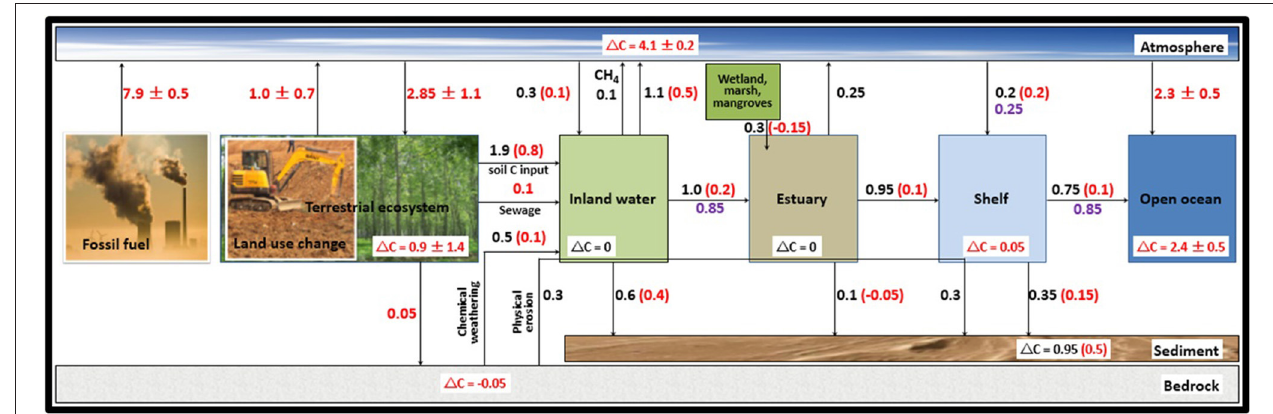
FIGURE 2 | Simplified schematic of the global carbon budget and its anthropogenic perturbation. All fluxes are in Pg C yr − 1 , rounded to ± 0.05 Pg C yr − 1 and represent the total carbon fluxes (organic and inorganic carbon). Arrows indicate direction of flux and 1 C refer to carbon accumulation within each reservoir. The numbers in the red color are the budget of anthropogenic CO 2 and numbers in the purple color are taken from Bauer et al. (2013). This figure is modified from Regnier et al. (2013) .